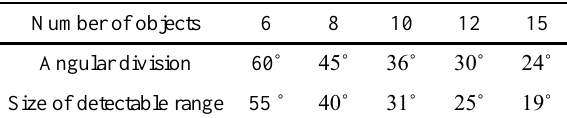
Table 1. Angle size for different interfaces Number of objects 6 8 10 12 15 Angular division 60˚ 45˚ 36˚ 30˚ 24˚ Size of detectable range 55 ˚ 40˚ 31˚ 25˚ 19˚ The diameter of the circles around the digits is 44 pix- els (1.13 ˚ visual angle). The distance from the center of the display to each circle is 150 pixels (3.87 ˚ visual angle).